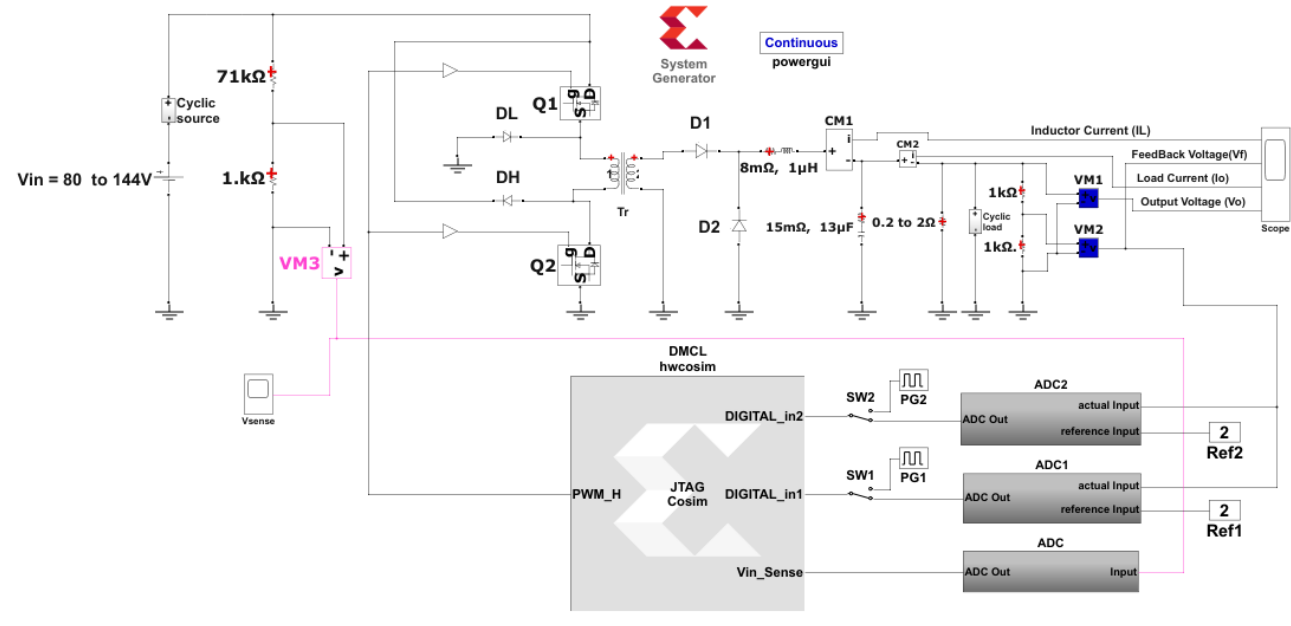
Figure 15. Converter output voltage and current responses during load disturbances in the presence of radiation fault injection (experiment 2).